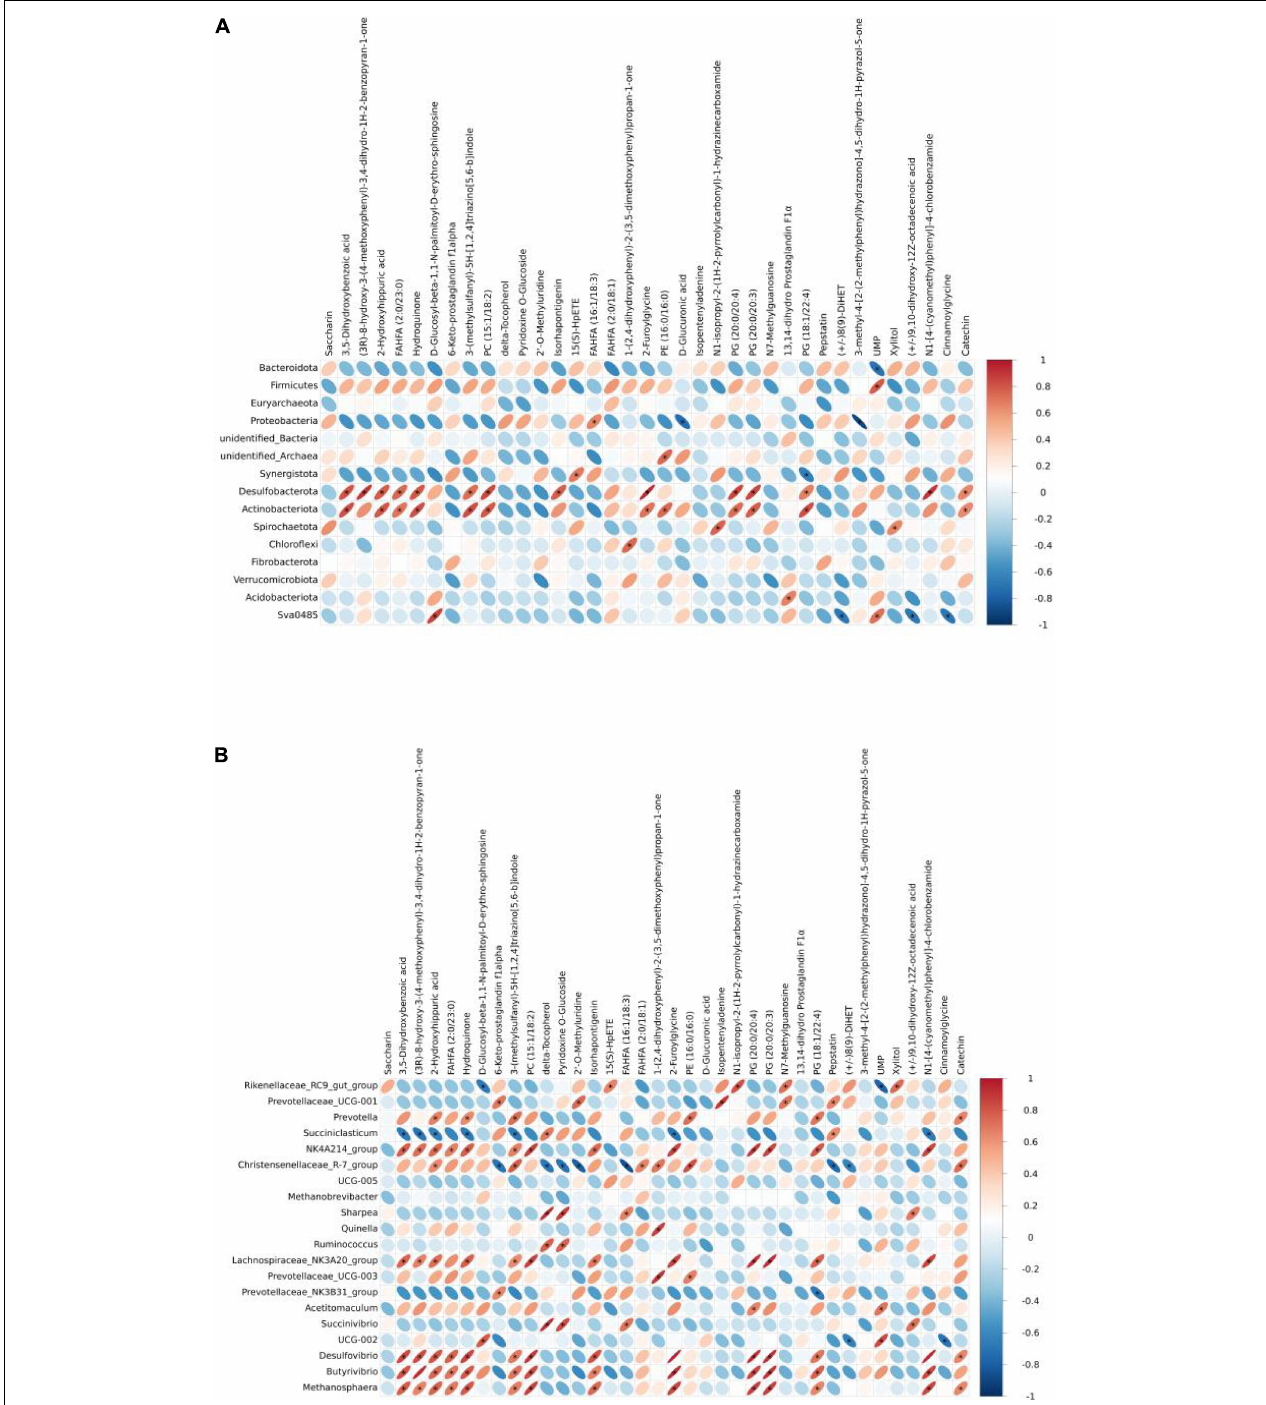
FIGURE 4 | Heatmap of the correlation between ruminal microbiota [ (A) phylum and (B) genus] and metabolites of yak calves.